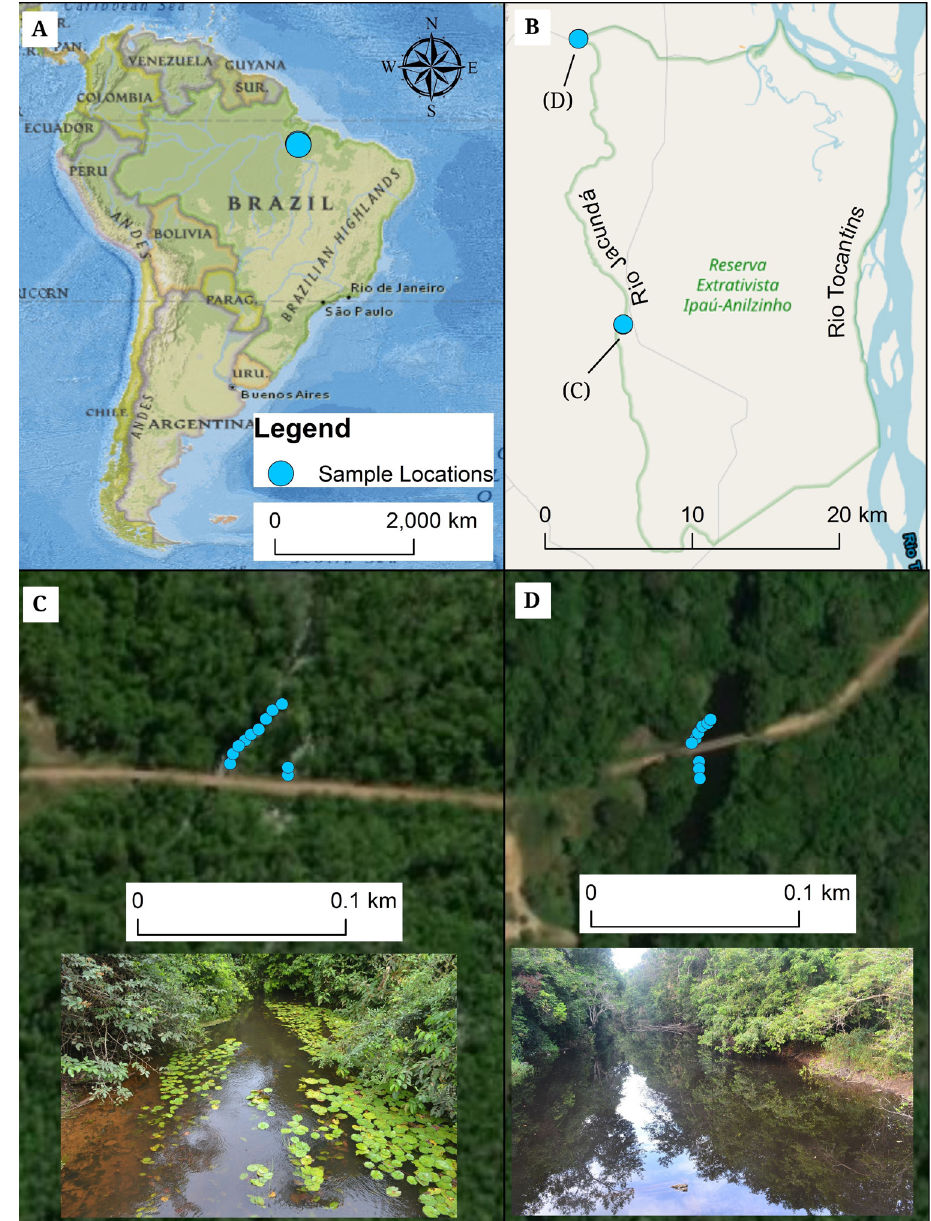
FIGURE 1 | Study area map illustrating A. The location of the rio Jacundá in the lower Amazon Basin, B. The two areas sampled on the western edge of the Reserva Extrativista Ipaú-Anilzinho, Pará, Brazil, C. The distribution of 11 sampling locations and a site photograph at the upstream area, and D. The distribution of nine sampling locations and a site photograph at the downstream